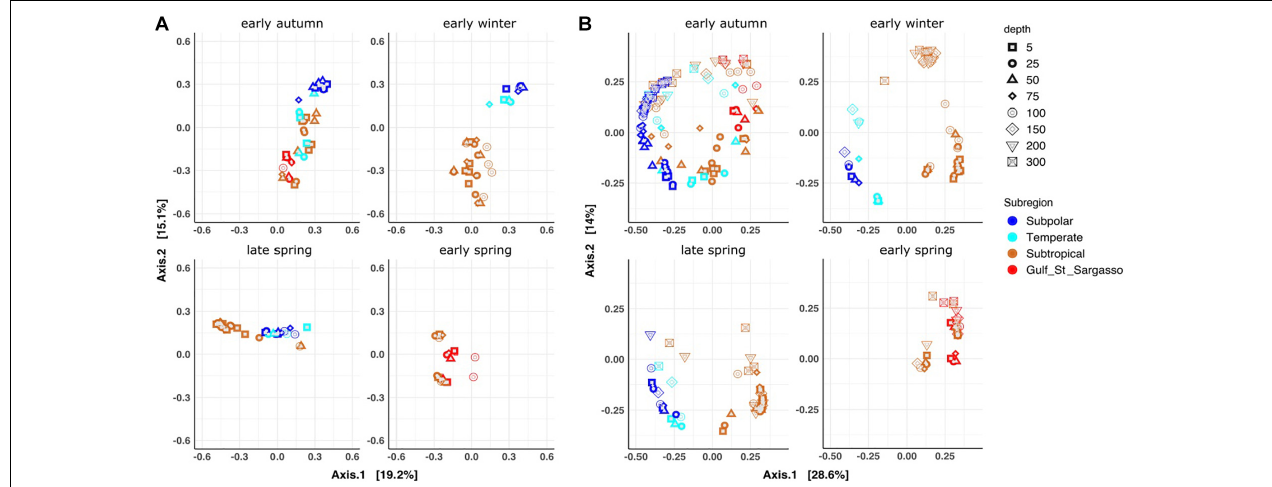
FIGURE 2 | Multidimensional scaling (MDS) ordination based on Bray-Curtis dissimilarities (A) Phytoplankton fraction of the datasets (0–100 m) (B) Bacterioplankton fraction of the datasets (0–300 m). Ordinations were divided in four panels representing each of the sampled seasons (clockwise: early autumn, early winter, early spring, late spring). Datasets in both panels are colored based on the MDT